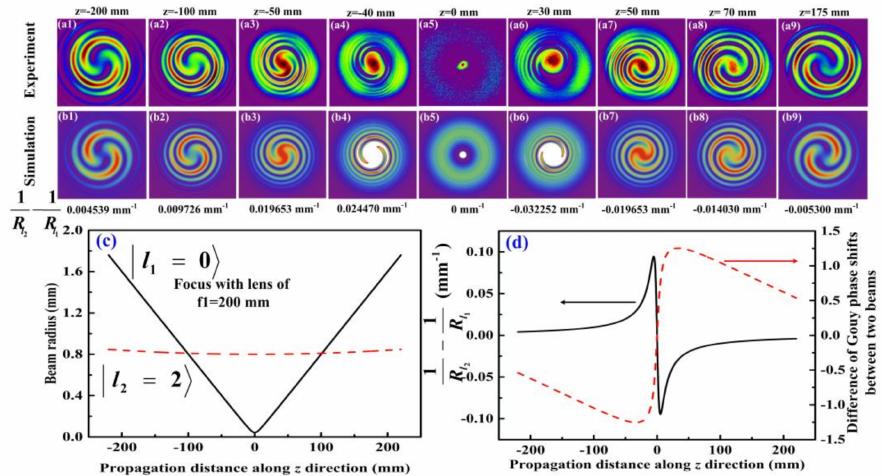
Figure 4. Coaxial interference characteristics between a focused TEM 00 Gaussian beam and a collimated vortex beam ( | l 2 = 2 (cid:105) ). Images ( a1 – a9 ) show the experimentally measured spiral pattern, and images ( b1 – b9 ) correspond to the numerical simulations. ( c , d ) are the calculated spot radii and wavefront curvature radii (difference of Gouy phase shifts) of two interference beams versus the propagation distance z , respectively.